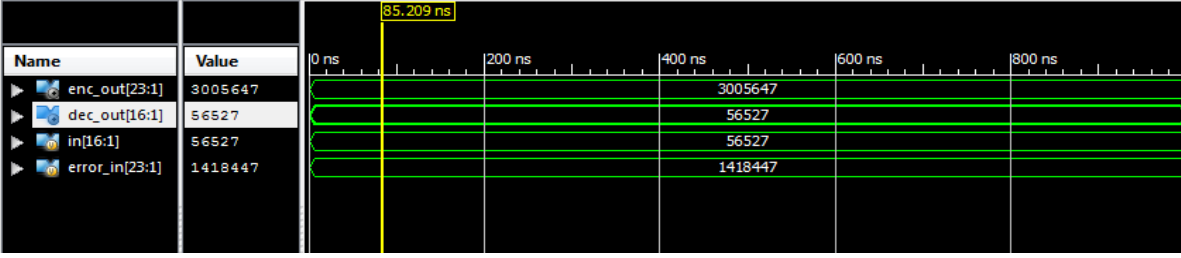
Figure 2. Simulation outcome of MBE-DCC.